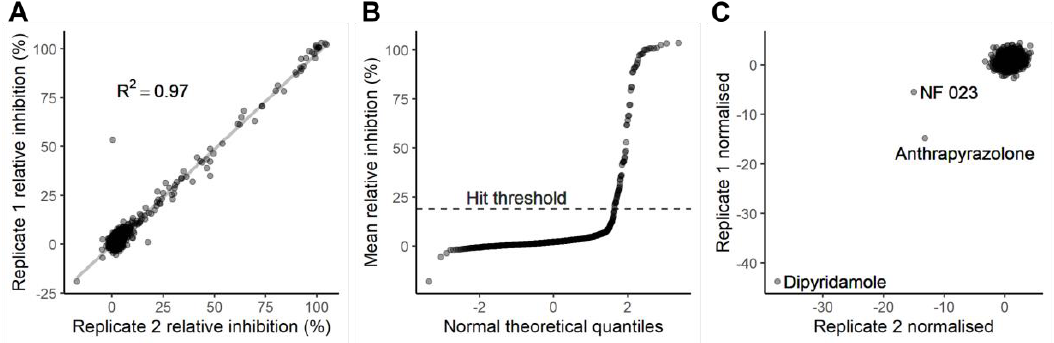
Figure 4. Screening the LOPAC ®1280 in duplicate. ( A ) Consistency between duplicates during screening. Each axis represents one replicate. The relative inhibition of protease activity for compounds was calculated as per Figure 3. ( B ) A quantile-quantile plot showing mean relative inhibition versus normal theoretical quantiles. The 19% relative inhibition used as a threshold for hit selection is indicated with a dashed line. ( C ) The effect of compounds on the R 528/477 in the absence of protease. Each axis represents one replicate and R 528/477 was normalised for each plate using sixteen eCFP-Venus biosensor (no protease) controls. Duplicate experiments were performed using separately purified eCFP-Venus biosensor and SARS-CoV-2 3CL pro , and all datapoints are shown.